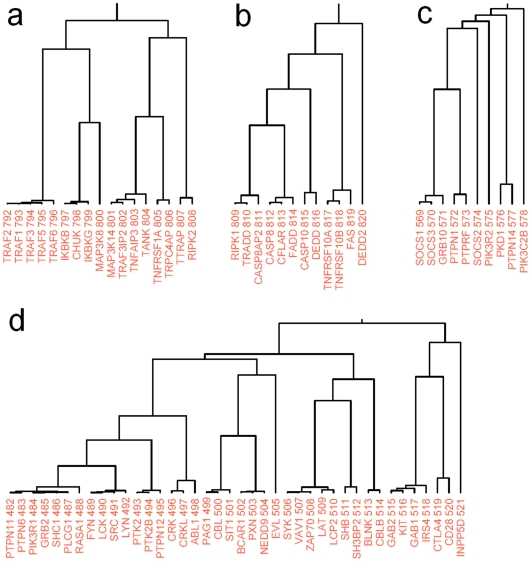
Four subclusters that are presumably involved in six signaling pathways (indices above protein names are their coordinates in Fig. 7
a).(a) Cluster for the NF-κB signaling pathway (P<3.2×10−20): TRAF1, TRAF3IP2, TANK, TRPC4AP and RIPK2 are potential pathway members. (b) Cluster for death receptor signaling pathway (P<2.4×10−19): CASP8AP2, DEDD and DEDD2 are potential members in this pathway. (c) Cluster for insulin receptor signaling pathway (P<2.4×10−10): SOCS2, PKD1, PTPN14 are potential pathway members. (d) Cluster for the immune response [T-cell receptor signaling (P<4.9×10−22), B-cell receptor signaling (P<1.1×10−17) and natural killer cell signaling (P<1.7×10−21)]: SRC, PTK2, PTK2B, PTPN12, CRK, CRKL, SIT1, PXN, NEDD9, EVL, KIT and IRS4 are potential members of the above three pathways.